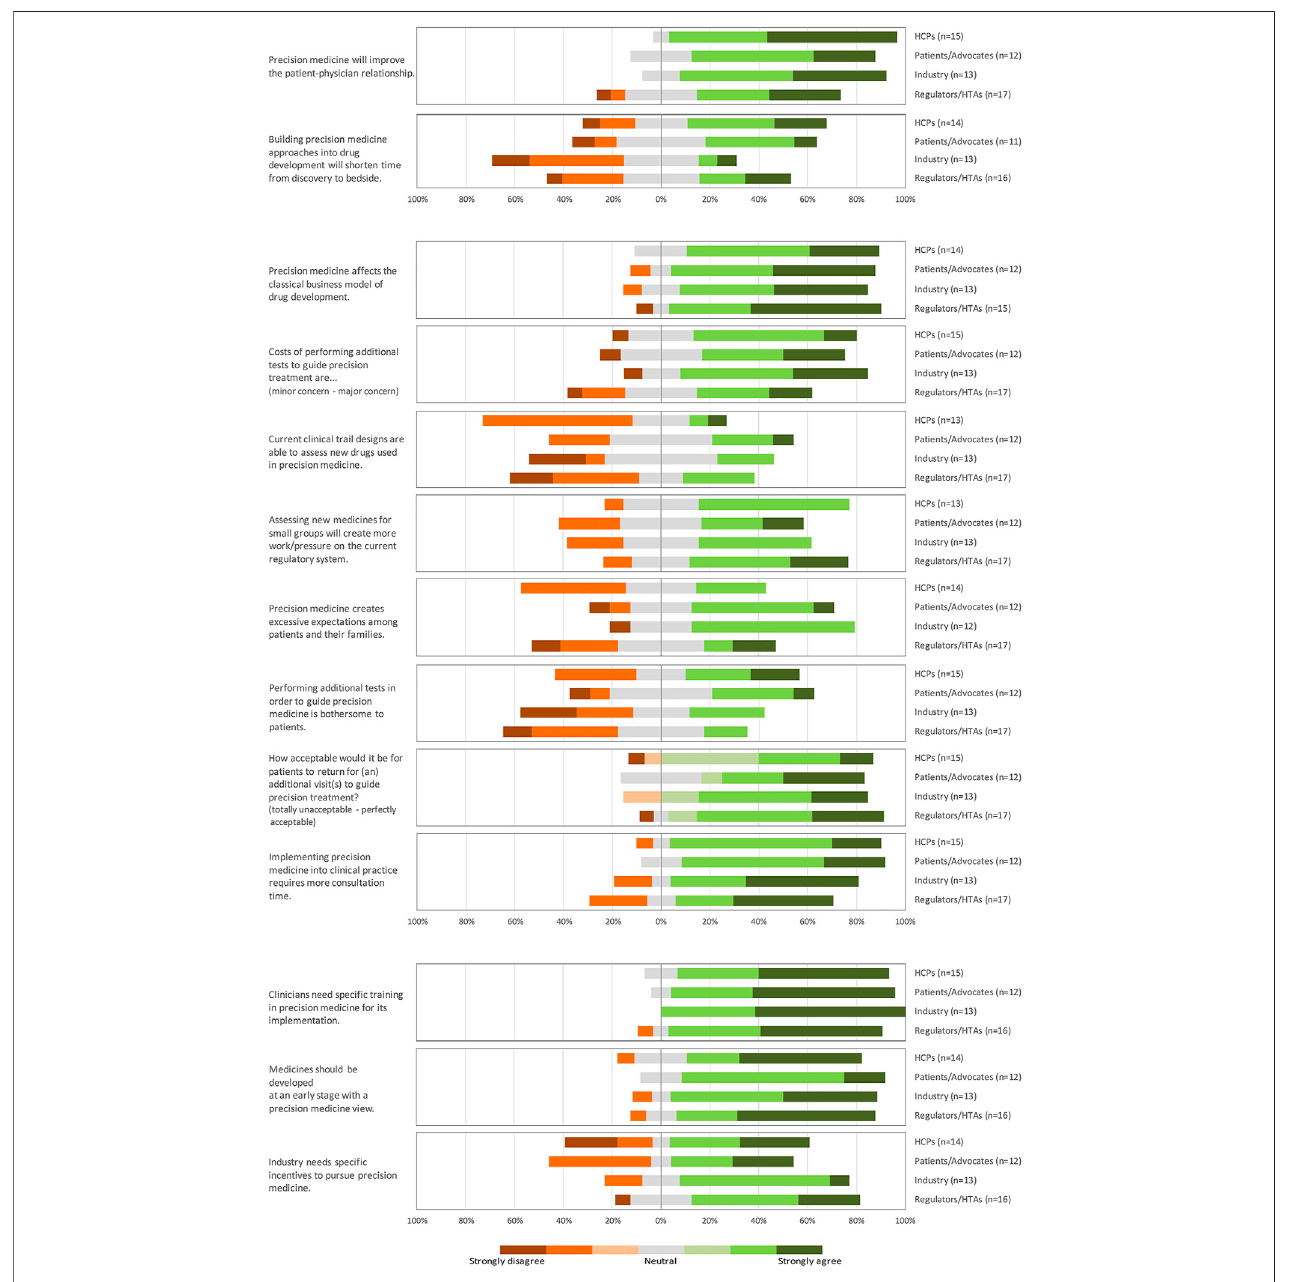
FIGURE 3 | Results of survey: stakeholder opinions of precision medicine. (HCPs, healthcare professionals; HTAs, health technology assessors).